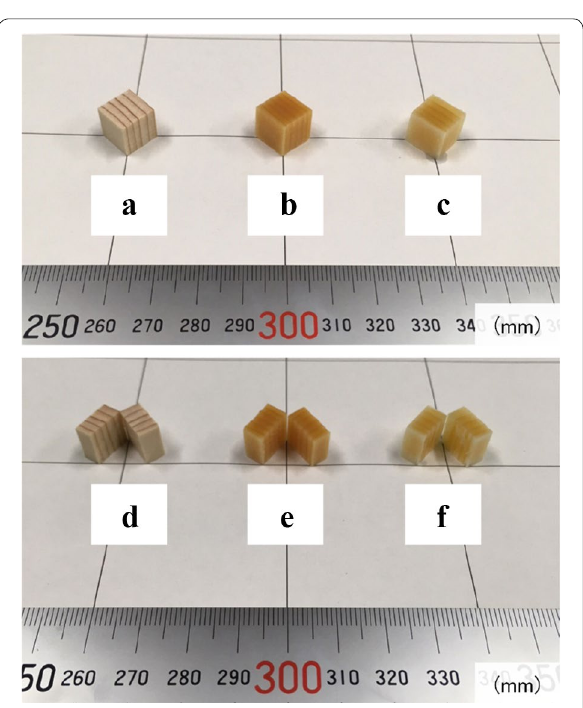
Fig. 5 Wood blocks ( a ) before bleaching, ( b ) after bleaching 4 times and ( c ) after bleaching 8 times without alcoholysis. d – f Wood blocks corresponding to ( a – c ) those were longitudinally cut along the radial direction to observe the inner